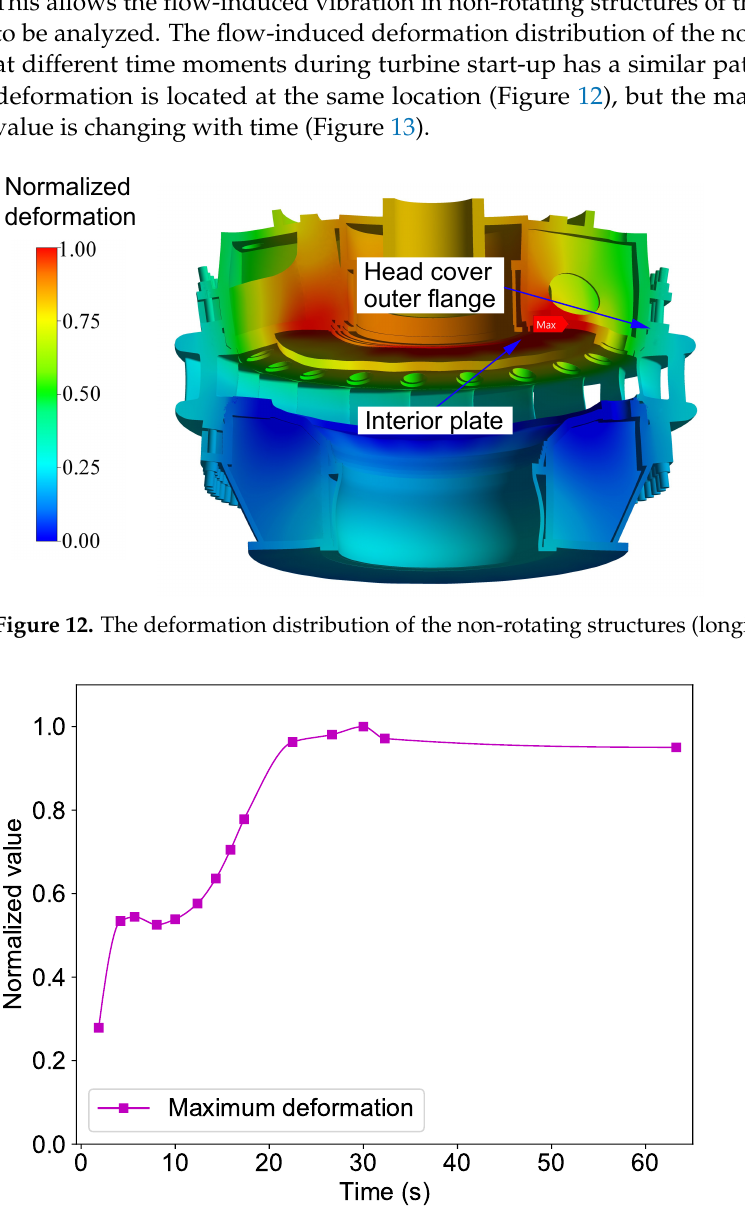
Figure 13. The maximum deformation of the non-rotating structures with